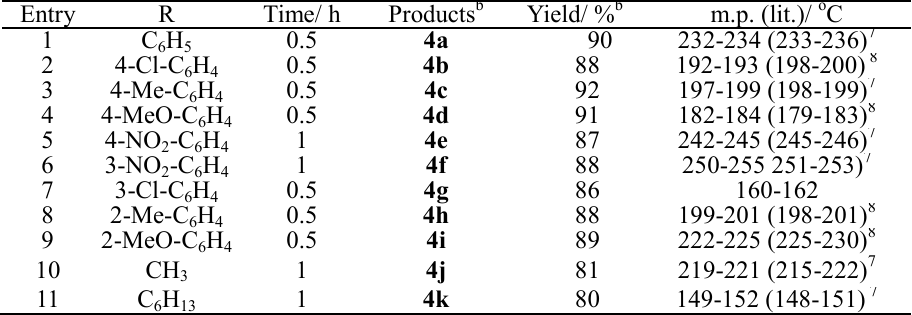
Table 2 . Preparation of 3-(2'-benzothiazolyl)-2,3-dihydroquinazolin-4(1 H )-ones a